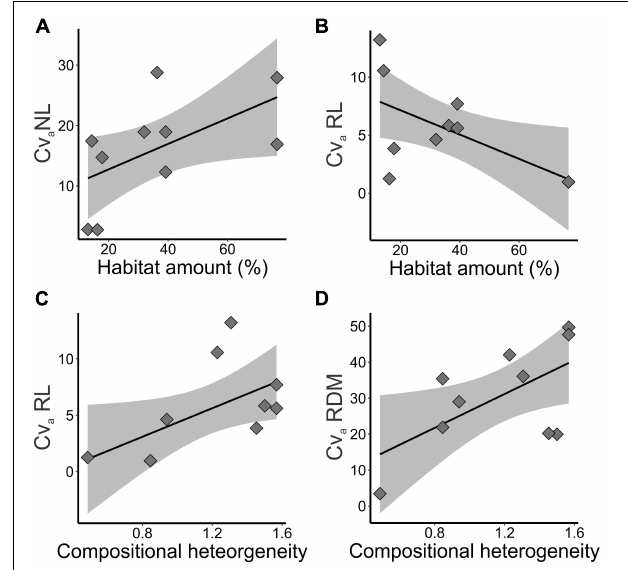
FIGURE 6 | Relationships of additive genetic coefficient of variation ( CV a %) of adaptive quantitative traits and landscape features in five landscapes and 10 sampling sites of Tabebuia aurea in the Brazilian Cerrado. (A) Additive genetic coefficient of variation ( CV a %) in number of leaves (NL) and habitat amount. (B) Additive genetic coefficient of variation ( CV a %) in root length (RL) and habitat amount. (C) Additive genetic coefficient of variation ( CV a %) in root length (RL) and compositional heterogeneity. (D) Additive genetic coefficient of variation ( CV a %) in dry root mass (RDM) and compositional heterogeneity. Black line is the linear regression fit and shaded area is the 95% confidence interval. Fits were significant ( p < 0.05) or marginally significant ( p <